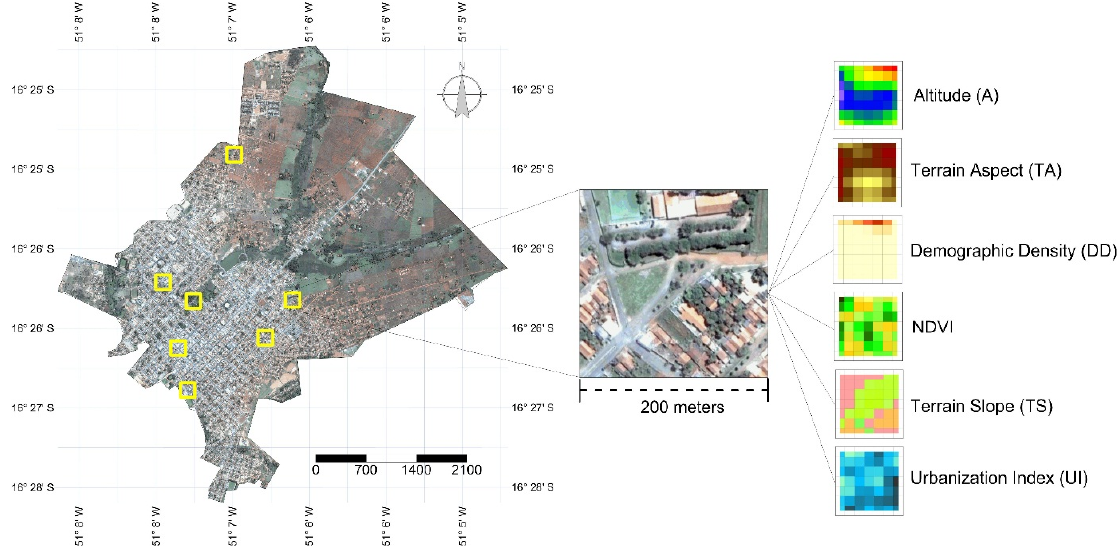
Figure 2. Measurement sites and method for obtaining urban-geographical variables.